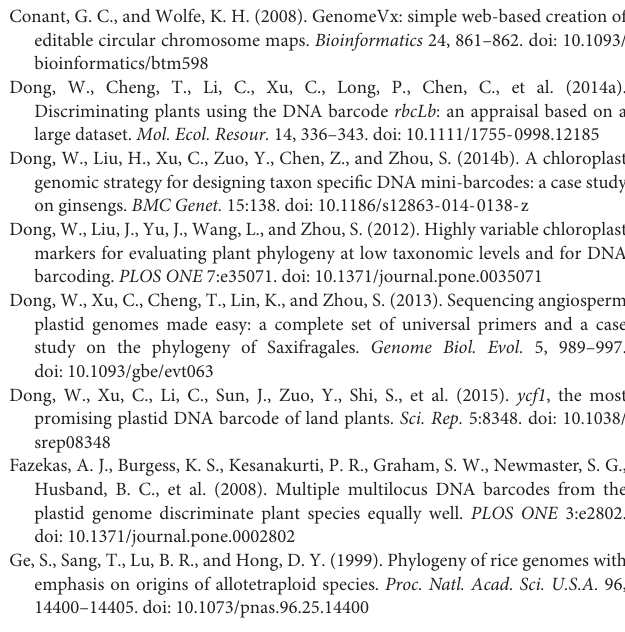
TABLE S2 | Sequence distances among the seven Oryza